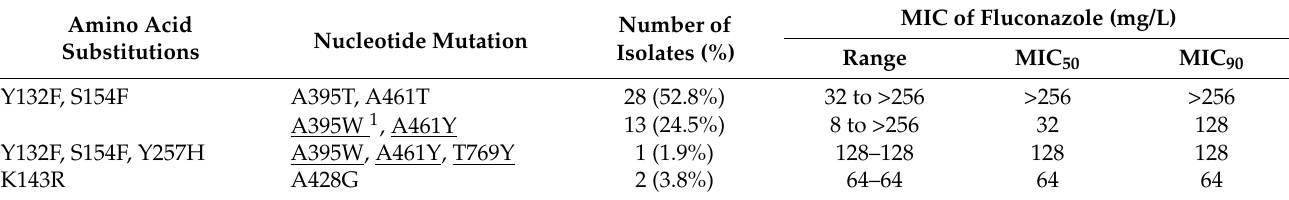
Table 3. Missense mutations in the ERG11 gene in resistant